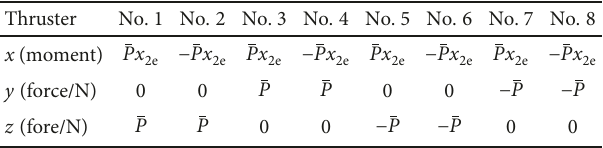
Table 1: Speci fi c information of each thruster.